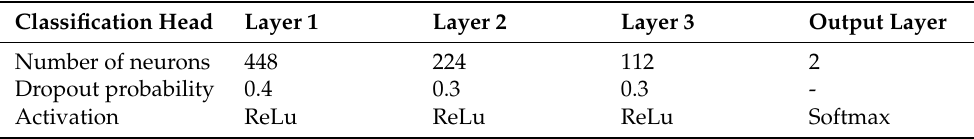
Table 8. Classification layers parameters summary: CNN-TL